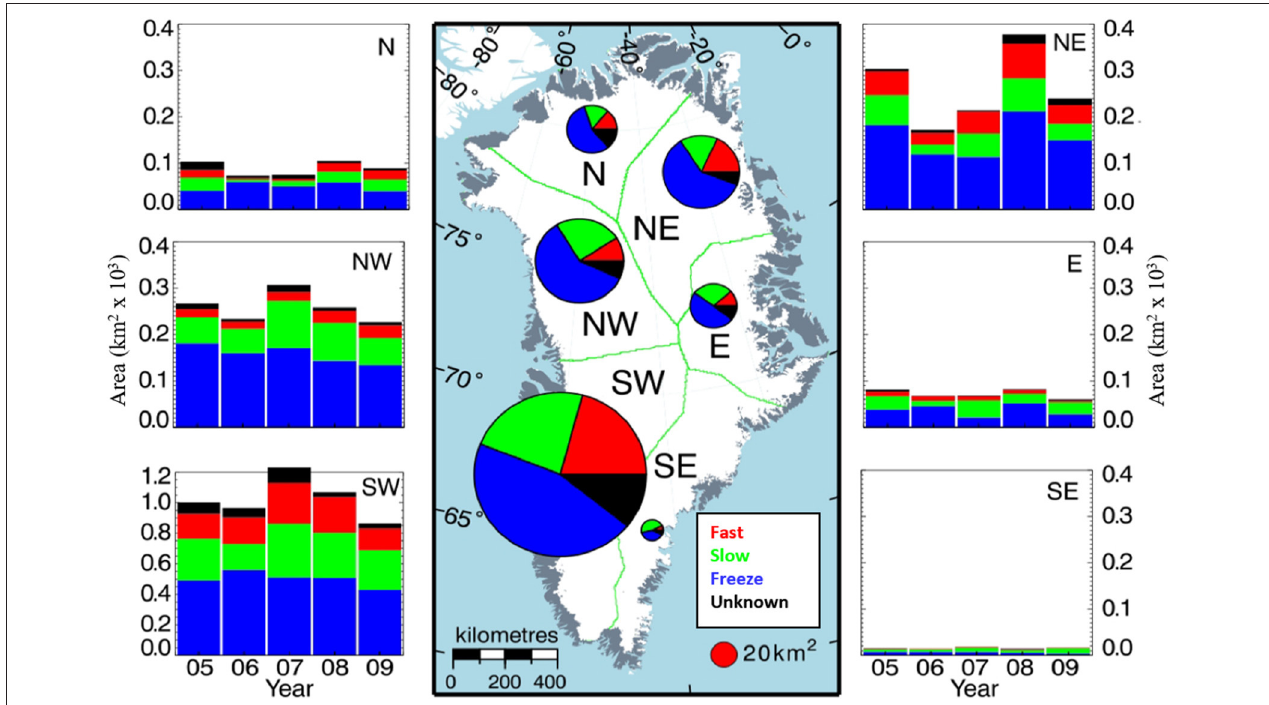
FIGURE 3 | The distribution of supraglacial lake (SGL) area and drainage type on the Greenland Ice Sheet. The central plot shows the mean area of fast draining SGLs (red), slow draining SGLs (green), SGLs that freeze over during winter (blue), and SGLs of an unknown drainage type (black) during 2005–2009. Bar charts show area and proportion of SGL drainage types per year. Adapted from Selmes et al.